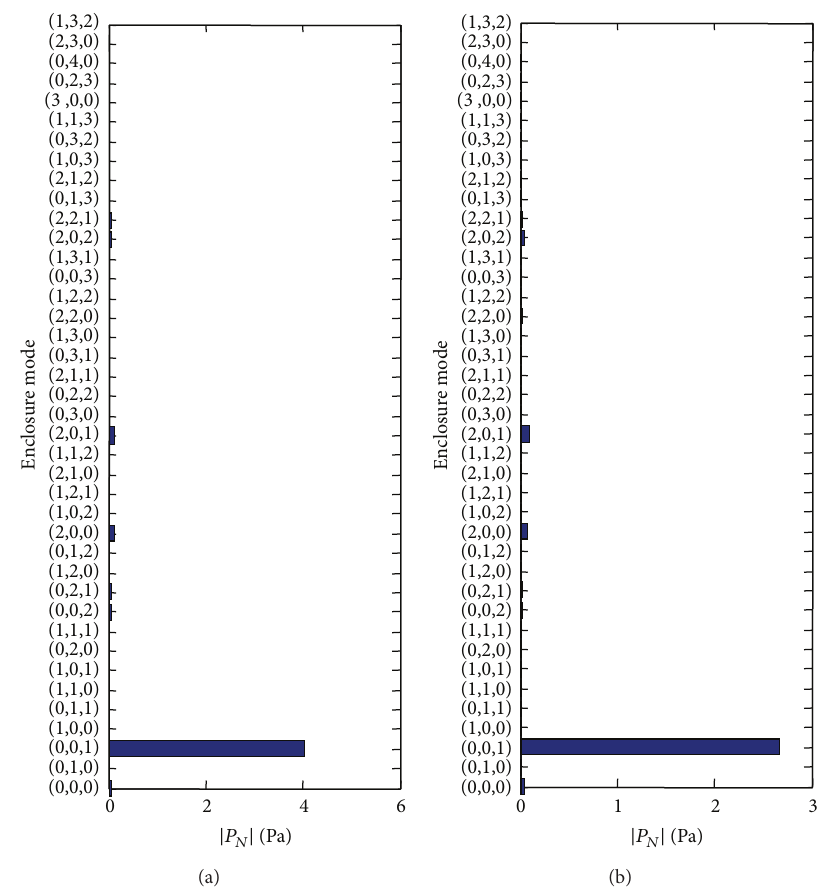
Figure 12: Modal amplitude of sound field in the enclosure: (a) the (0,0,1) enclosure-controlled mode; (b) the (3,1) panel-controlled mode. = 0.722 m, 𝑇 = 15 s, 𝑇 = 0.5 ℎ = 0.007 m, 𝐿 𝑍 𝑎𝑁 𝑝𝑀